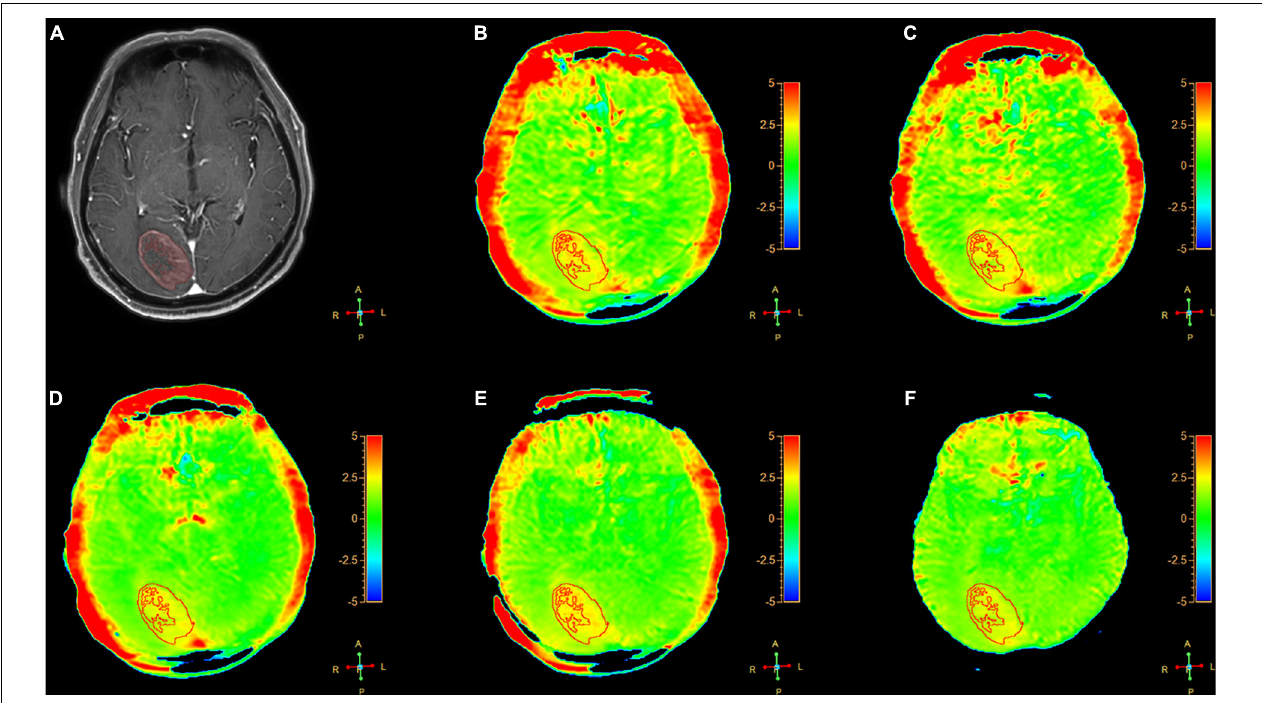
FIGURE 3 | A 64-year-old female patient with metastasis in brain: (A) Gd-T1W; (B–F) APTw images by SENSE (AF 1.6) and CS-SENSE (AFs of 2, 3, 4, and 5). The ROIs were obtained manually on the Gd-T1W image and copied to the others as shown.